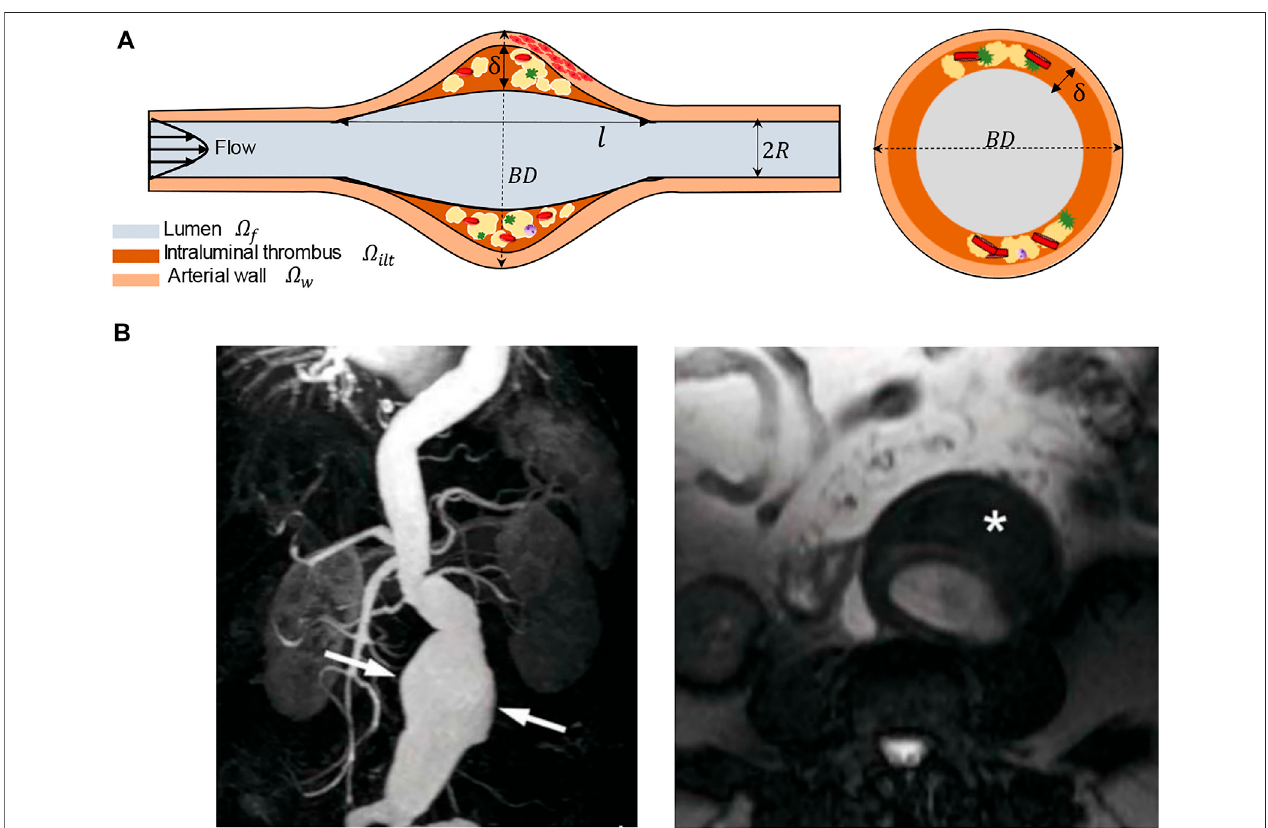
FIGURE 1 | (A) Schematic of the idealized, three-dimensional axially symmetric model of an AAA, where BD represents the bulge diameter, l denotes ILT length, and δ is the ILT thickness. (B) Left: coronal plane view of a magnetic resonance angiography (MRA) of a clinical infrarenal AAA. Extensive dilatation (arrows) and renal arteriesonbothsidescanbeobserved.TherenalarteriesinMRAimagearenotincludedinthecomputationalmodel.Right:theimagedemonstratesaneurysmformation and thrombus-covered region (asterisk). MRA images are taken from (Douek, 2005).